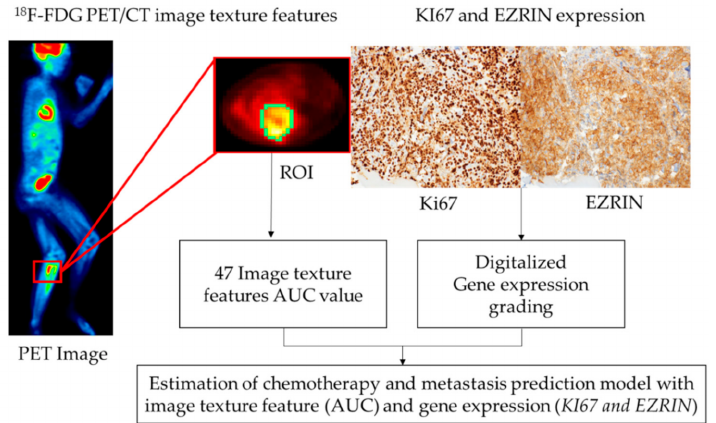
Figure 1. Diagram of the process for generation of the prediction model with image texture features and gene